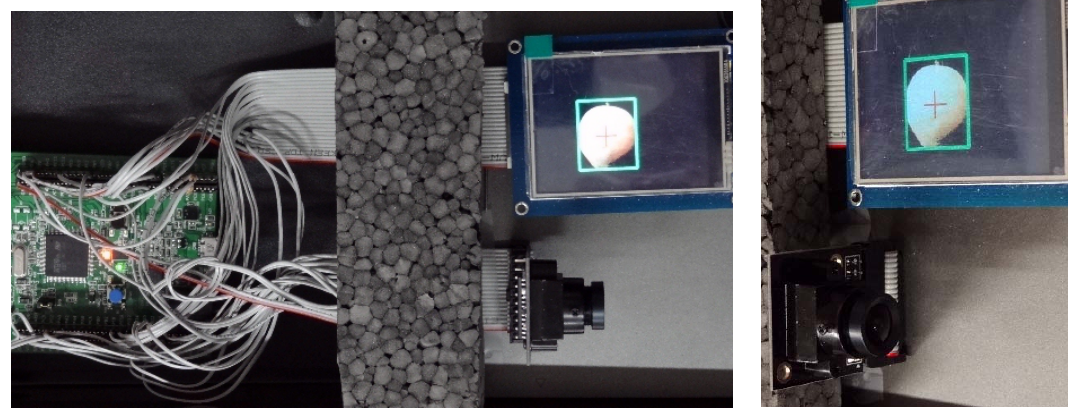
Figure 1. The camera module, the board processor and the auxiliary color